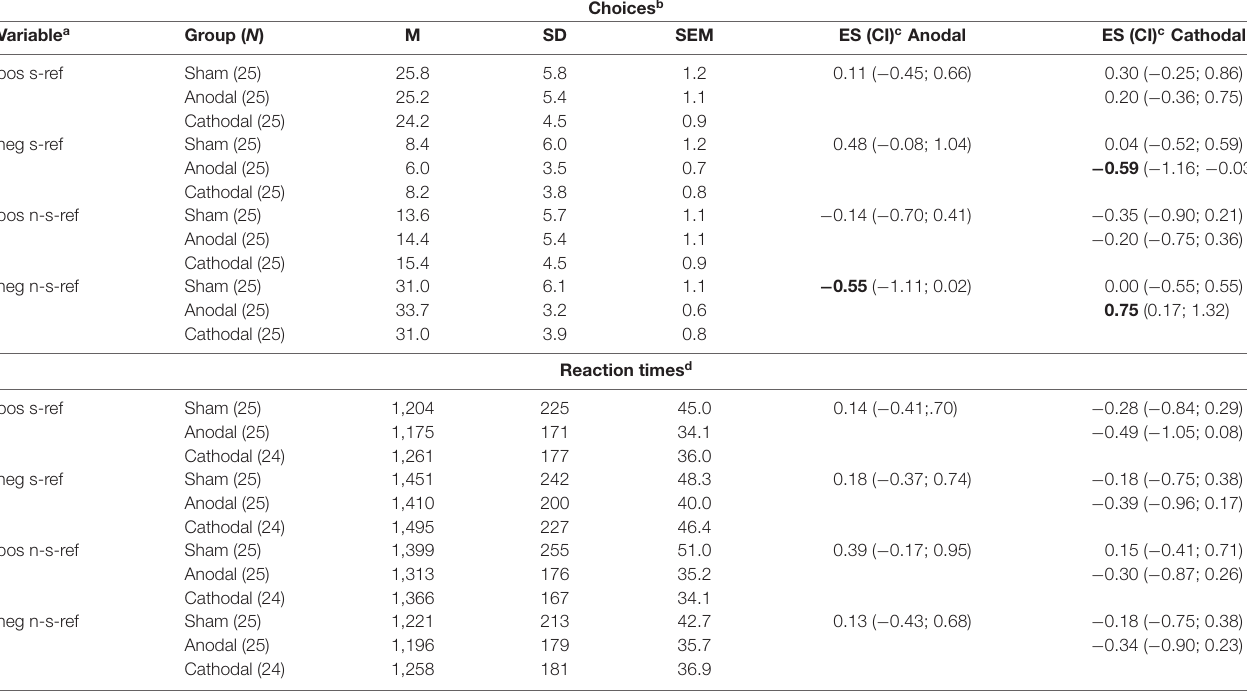
TABLE 1 | The number of chosen adjectives and reaction times in the stimulation groups.